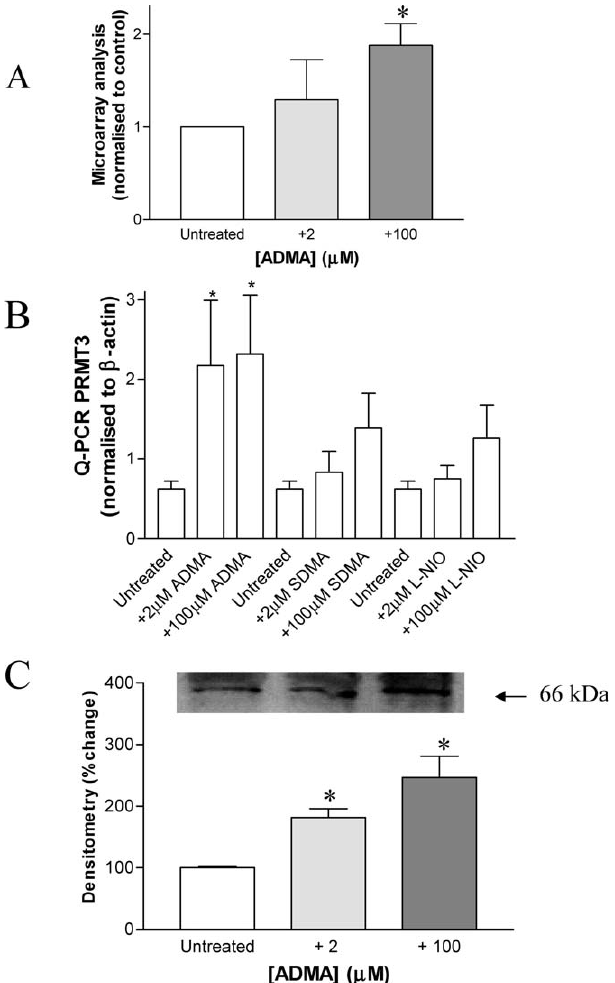
Figure 4. ADMA Alters PRMT3 Gene Expression and Protein Levels (A) PRMT3 levels are changed by ADMA on U133A GeneChips where n ¼ 3 (untreated versus 100 l M: 1.88-fold increase, p ¼ 0.034). (B) PRMT3 mRNA is changed in HCAEC following 24-h exposure to ADMA (2 and 100 l M) but not SDMA (100 l M) or L-NIO (100 l M), measured by Q-PCR (* p , 0.05 and ** p , 0.01, where n ¼ 8). (C) PRMT3 protein levels are increased in HCAEC following 24-h